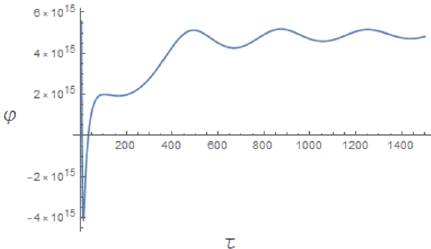
Figure 4 . Plot of the oscillation of ’ during reheating, showing its evolution and subsequent trap- ping around one of its potential minima, as governed by eq. (5.37) when neglecting the production of driven motion in (cid:18) , that is _ (cid:18) ’ _ (cid:31)= (cid:3) (cid:8)(cid:8) . The horizontal axis is in the units (cid:28) = (cid:22) inf t , and the CP example parameters used are (cid:21) (cid:30) = 10 (cid:0) 8 , (cid:15) (cid:18) = 4 (cid:2) 10 (cid:0) 5 , (cid:24) = 2 (cid:2) 10 4 , (cid:16) = 100, and v ’ = 5 (cid:2) 10 15